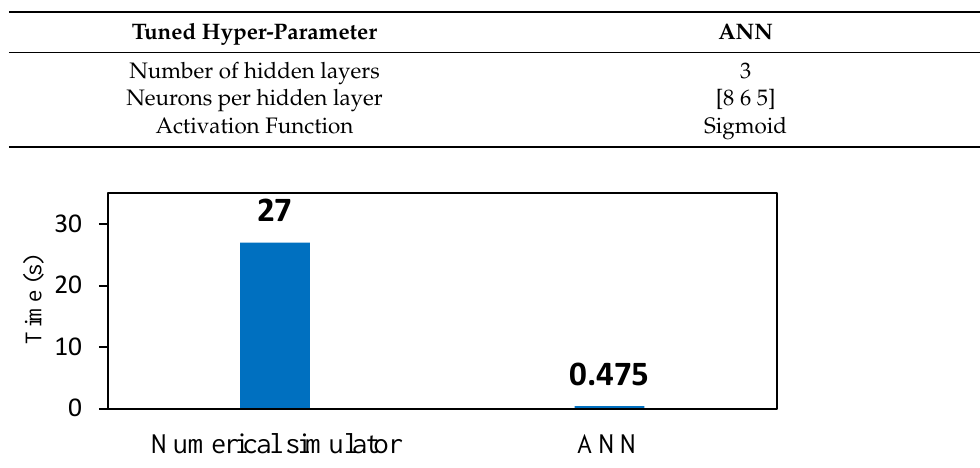
Table 3. The optimized hyper-parameters for the ANN model.